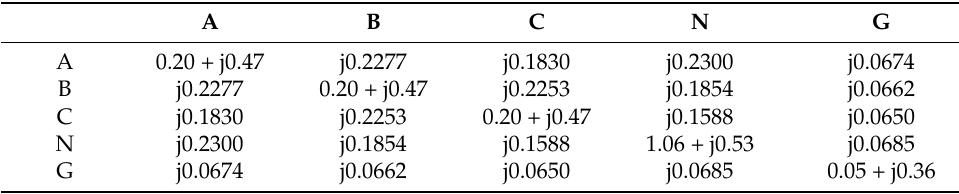
Table A2. The calculated results of the original branch model ( Ω /km).